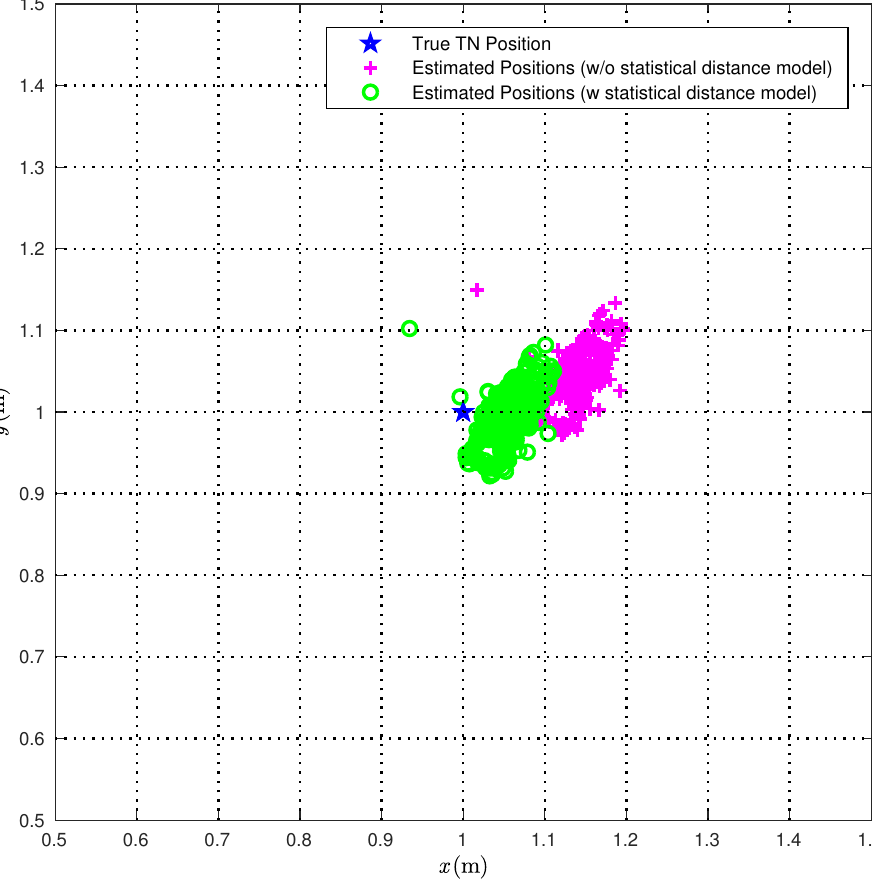
Figure 10. The 1000 position estimates obtained with the CI localization algorithm are shown (magenta plus), together with the 1000 position estimates obtained when taking into account the statistical model for range estimates (green circles) and the TN (blue